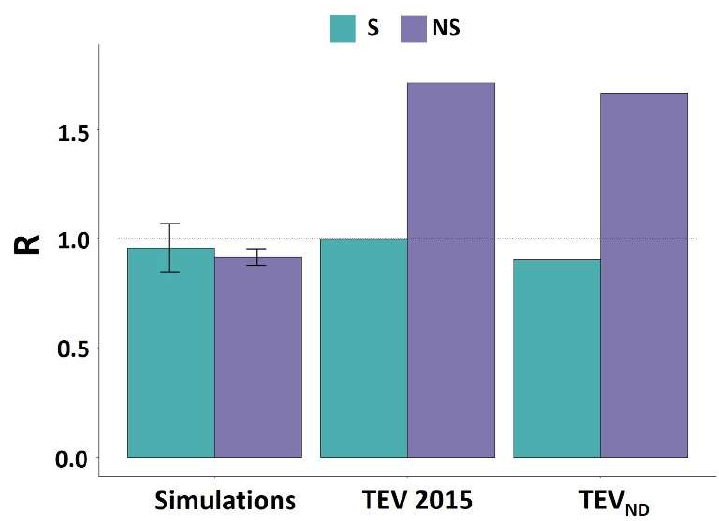
Figure 3. Ratio between the percentage of mutation (S or NS) present in IDRs and ORs for the TEV genome. For datasets from the two other studies [11,12] regarding TuMV and PVY, please refer to the supplemental data. Supplemental Table 2. p values of Xhi 2 test for percentage of NS mutations in IDRs between simulated and ex- perimental data (TEV 2015, PVY 2015, PVY 2017) or natural diversity (TEV ND , PVY ND , TuMV ND ). There was no experimental datasets available for TuMV. Significance, p < 0.05.